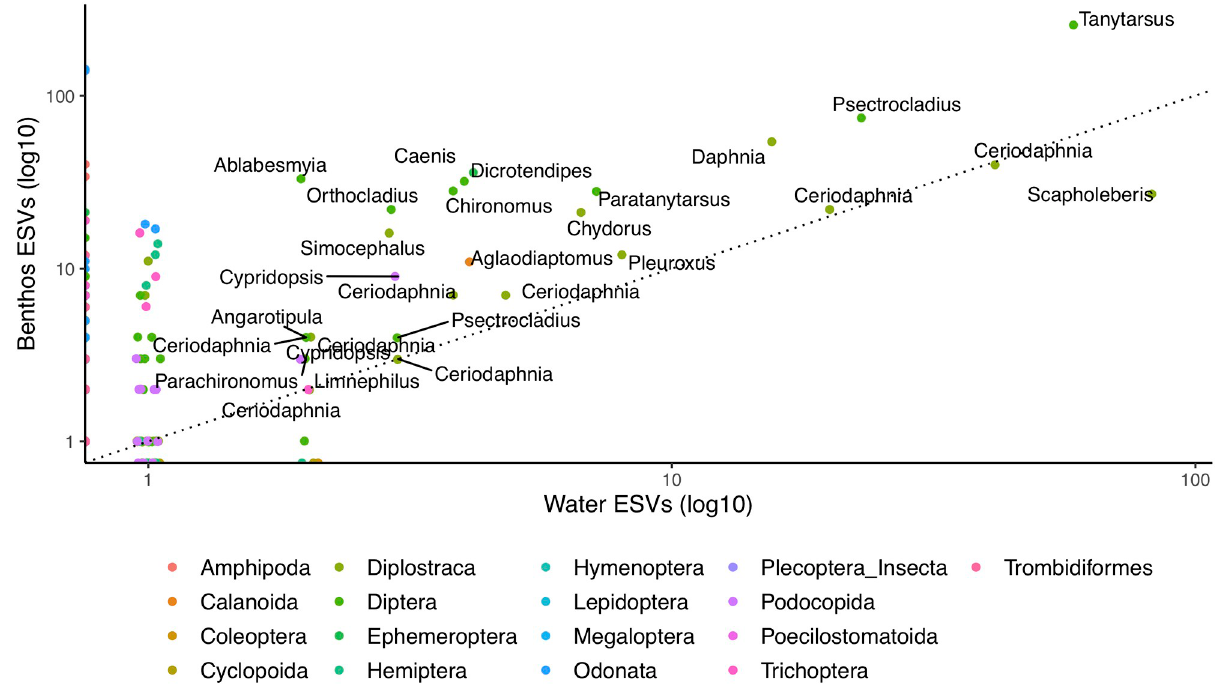
Fig 3. A greater diversity of arthropod sequence variants are detected from benthic samples. Each point represents a genus identified with high confidence and the number of benthic and water exact sequence variants (ESVs) with this taxonomic assignment. Only genera represented by at least 2 ESVs in both benthic and water samples are labelled in the plot for clarity. The points are color coded for the 17 arthropod orders detected in this study. A 1:1 correspondence line (dotted) is also shown. Points that fall above this line are represented by a greater number of ESVs from benthic samples. A log10 scale is shown on each axis to improve the spread of points with small